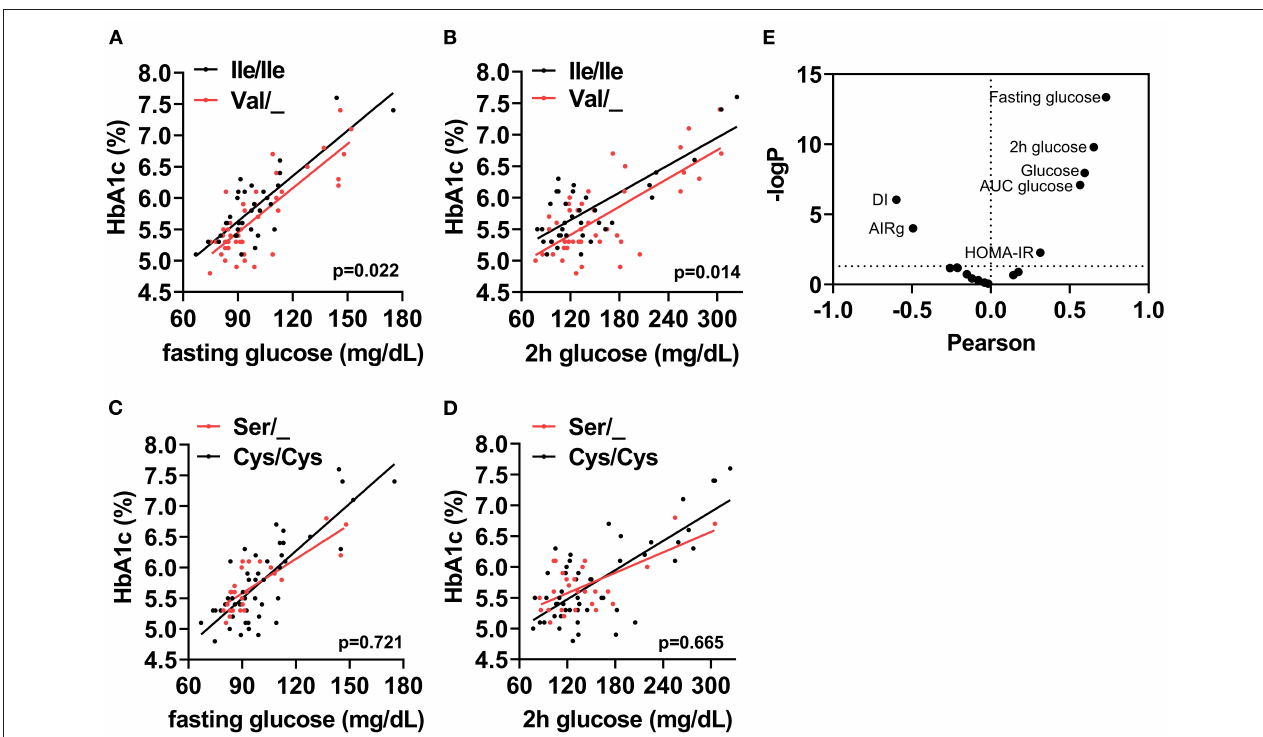
FIGURE 1 | The TAS1R2 -(Val) variant is associated with HbA 1c in humans. Association between (A) Fasting glucose, or (B) 2h glucose post OGTT (2h glucose) with percent glycated hemoglobin (HbA 1c ) in Ile/Ile (black) and Val carriers (red) using a linear regression model (p value for intercepts). (C) Fasting glucose, or (D) 2h glucose post OGTT (2h glucose) with percent glycated hemoglobin (HbA1c) in Cys/Cys (black) and Ser carriers (red) using a linear regression model ( p value for intercepts). All values shown in A-D are unadjusted. (E) Correlation coefficient (Pearson) and statistical significance [–Log(p)] volcano plot for all assessed variables (i.e., baseline, OGTT and FSIVGTT) with HbA 1c . Horizontal dotted line shows statistical significance of p < 0.05 or higher. Only variables with p < 0.05 are labeled. AUC, area under curve; DI, disposition index; AIRg, acute insulin response to glucose index; HOMA-IR, homeostatic model assessment for insulin resistance.